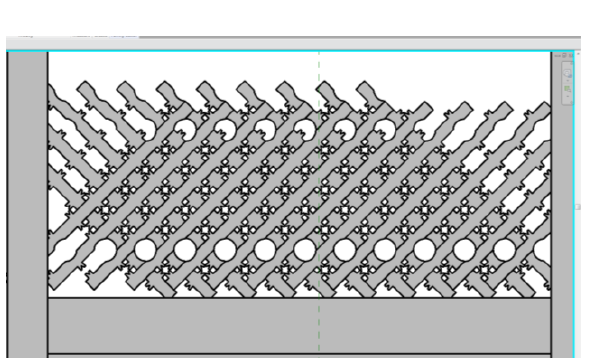
Figure 4: example of the Manjur pattern in old Jeddah (Greenlaw, 1995).